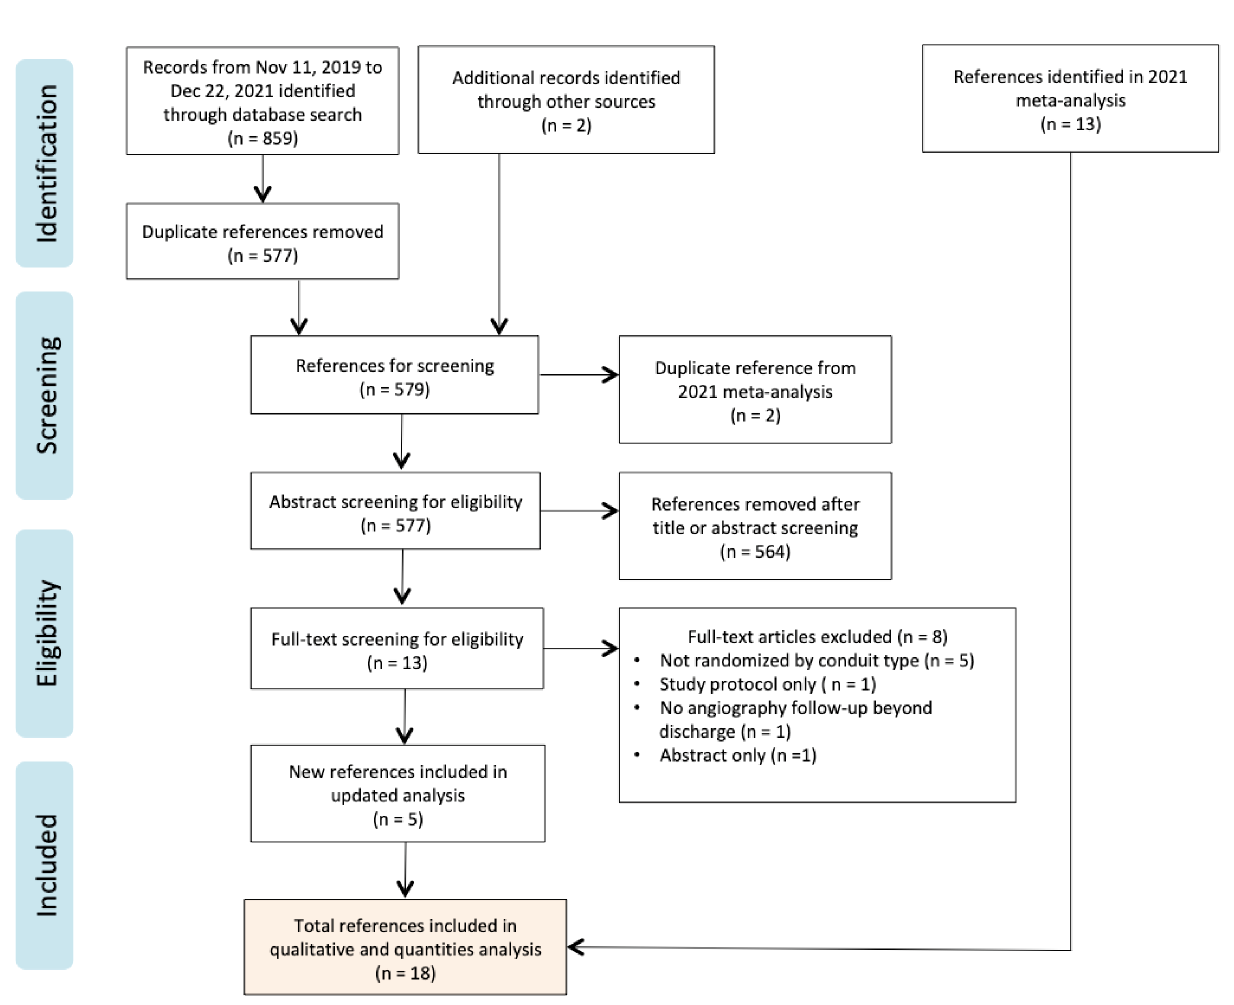
Fig. S1 - Preferred Reporting Items for Systematic Reviews and Meta-Analyses flow